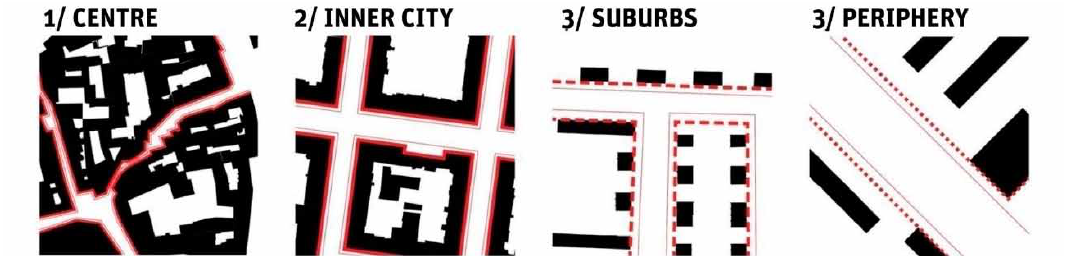
fig. 1. localities with different character – relation between streetline and building line Source: IPr Praha,